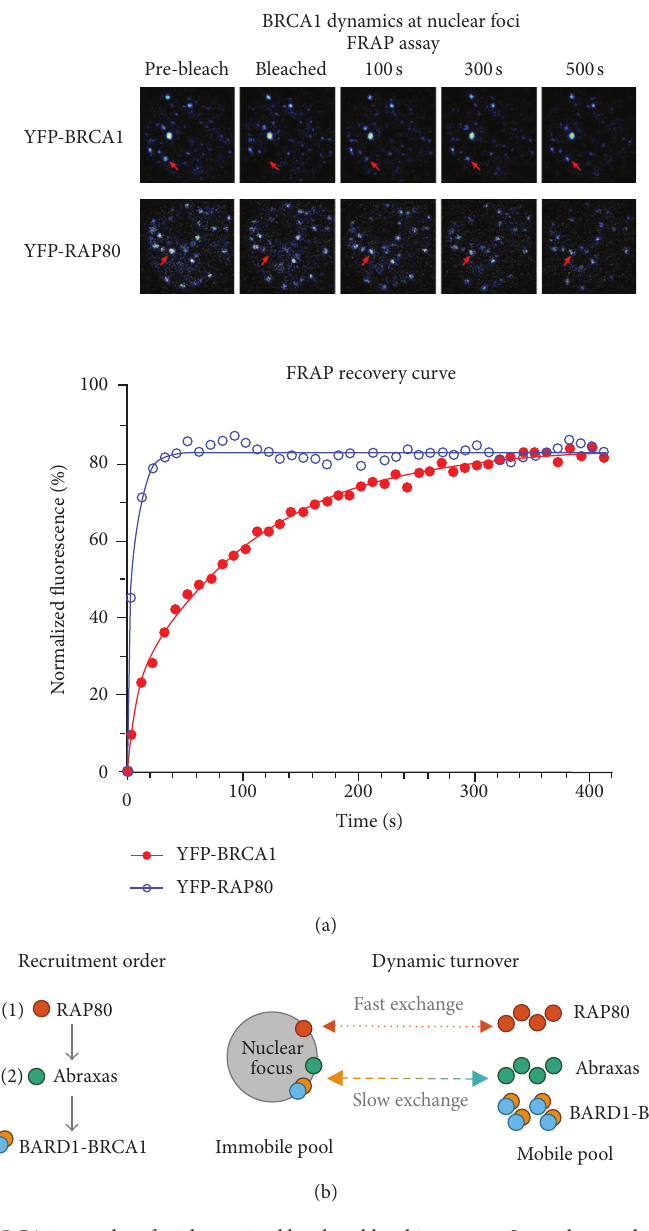
F 4: Dynamic exchange of BRCA1 at nuclear foci determined by photobleaching assays. Several teams have studied the kinetics of recovery of DNA repair factors at DNA breaks by �uorescence recovery aer photobleaching (FRAP) assay, although in the case of BRCA1-A complex proteins this was most oen at laser-induced microirradiation lines that span the entire nucleus [77]. (a) A recent study used stable inducible cell lines to quantify and compare the dynamics of BRCA1 and associated DNA repair proteins at individual IR-induced foci in the nucleus [76]. is revealed a rapid recovery of different components, including BRCA1 and BARD1 which moved to and from foci as a dimer, and an extremely rapid on-off rate of the upstream factor RAP80. is is illustrated by rapid recovery of YFP-RAP80 at an individual focus (red arrow) following laser bleaching of the focal �uorescence (see also recovery curve graph). (b) e �ndings of that work are consistent with a hierarchy of protein targeting to foci (see le panel), but present a new perspective in terms of the dynamic nature of components at repair foci (see right panel). is �gure was adapted from